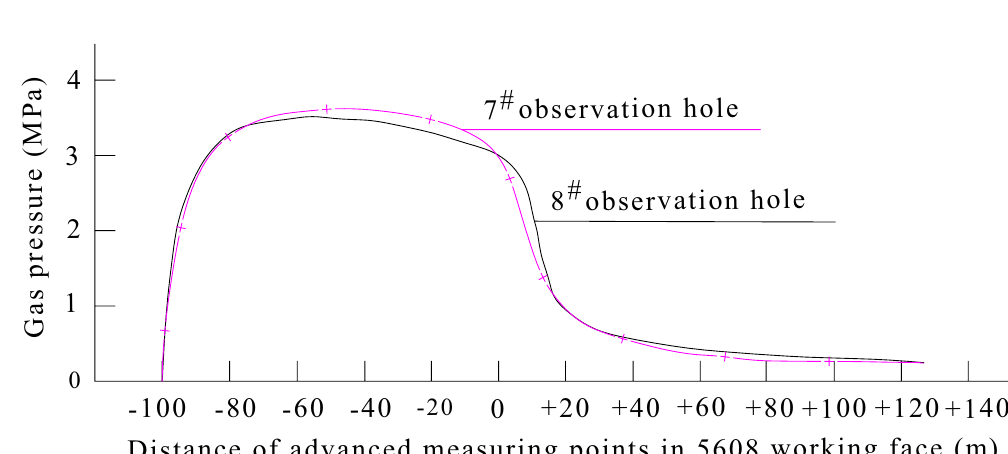
Figure 6. Relationship between the coal seam gas pressure and gas content.